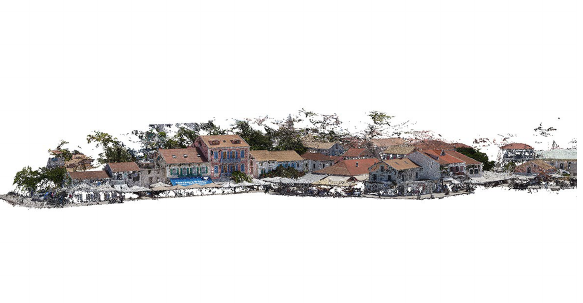
Figure 16 . Fiskardo Port, dense point cloud, as seen from the dock.